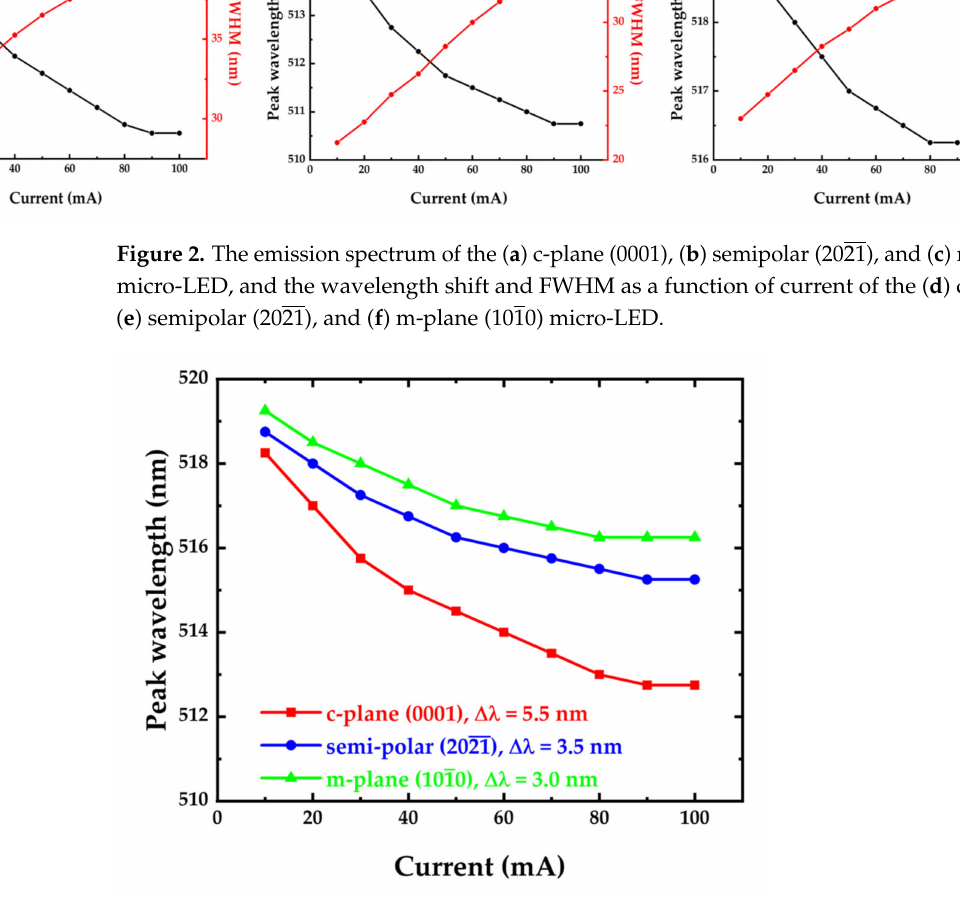
Figure 3. The peak wavelength of the simulated c-plane (0001), semipolar (2021), and m-plane (1010) micro-LEDs as a function of